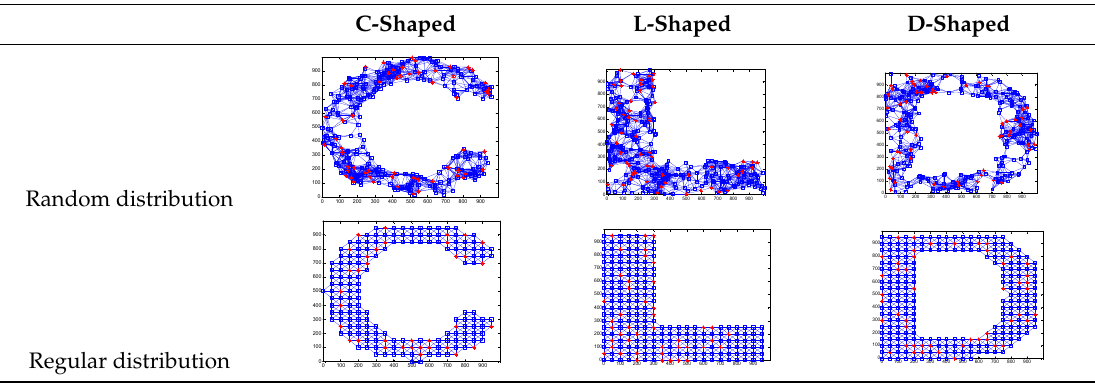
Table 1. The simulation scenarios.